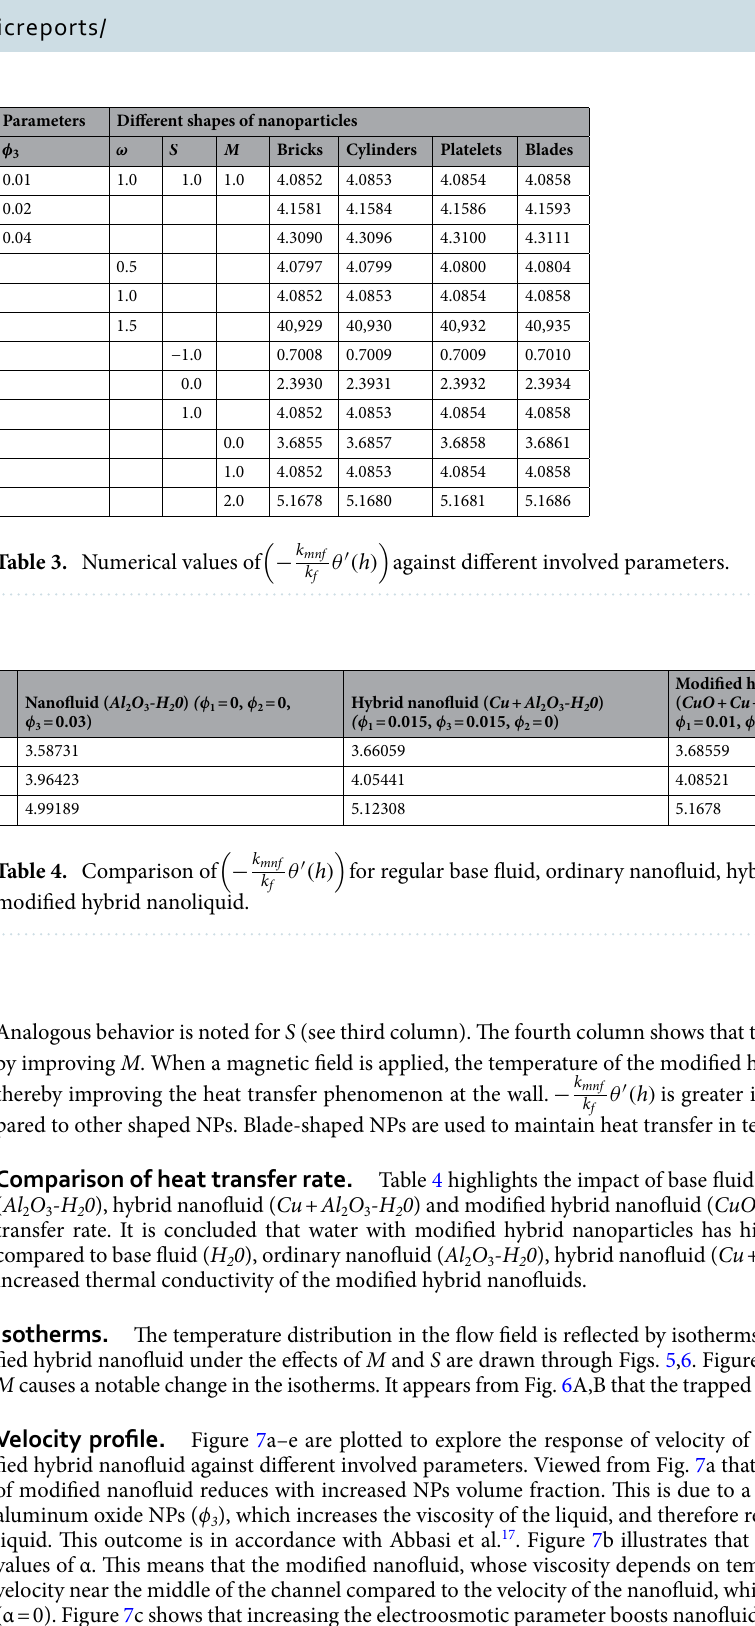
Figure 7a–e are plotted to explore the response of velocity of ( Cu + CuO + Al 2 O 3 ) modi- fied hybrid nanofluid against different involved parameters. Viewed from Fig. 7a that the magnitude of velocity of modified nanofluid reduces with increased NPs volume fraction. This is due to a higher volume fraction of aluminum oxide NPs ( ϕ 3 ), which increases the viscosity of the liquid, and therefore resists the movement of the liquid. This outcome is in accordance with Abbasi et al. 17 . Figure 7b illustrates that velocity grows with rising values of α. This means that the modified nanofluid, whose viscosity depends on temperature, reflects a higher velocity near the middle of the channel compared to the velocity of the nanofluid, which has a constant viscosity (α = 0). Figure 7c shows that increasing the electroosmotic parameter boosts nanofluid flow. The phenomenon of ELD affects an electroosmotic parameter. Velocity declines for larger ω when U hs = −1.0. Figure 7d outlines that nanofluid flow is reduced by strengthening U hs . For auxiliary electric field velocity is higher and lower for the opposing electric field. U hs is reliant on the electric field, which governs the flow in this case. The applied electric field has a direct relationship with U hs . Thus, at the positive value of U hs it acts as a hindering force in the momen- tum equation, and at negative values it maintains the fluid flow. A similar behavior on velocity is also seen for higher Hartman number (see Fig. 7e). A Lorentz force is created in the flow when the Hartmann number ( M ) is increased, which causes the velocity to reduce.